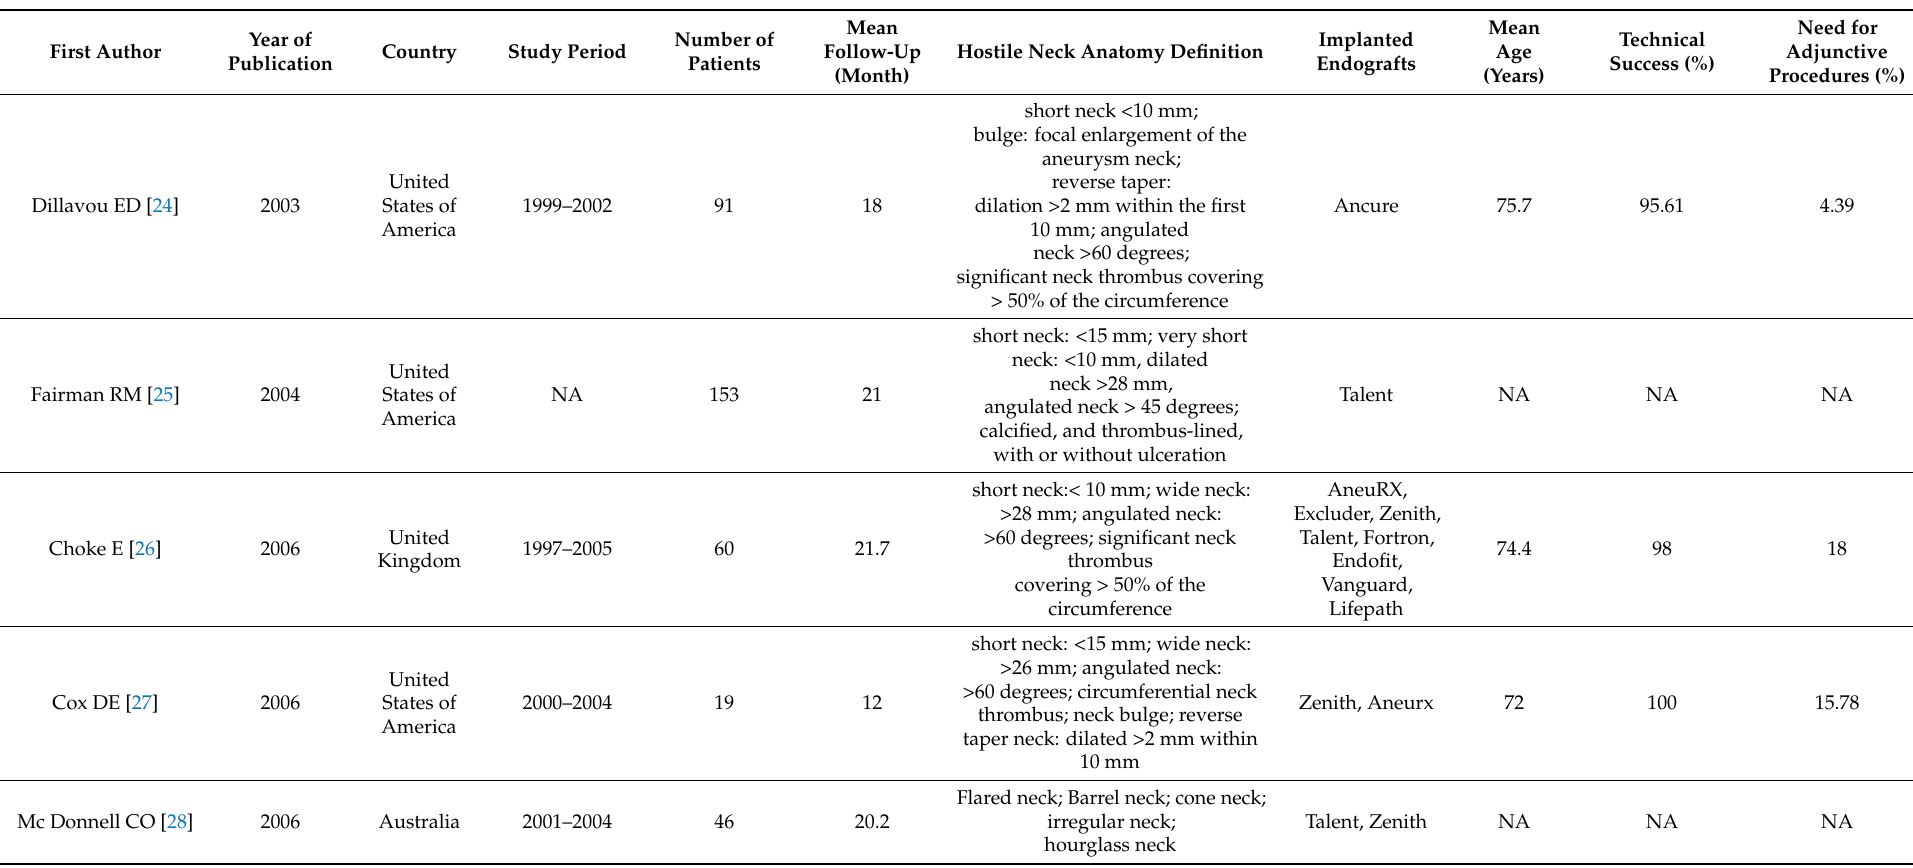
Table 1. Authors, years of publication, countries of origin, study period, number of patients, follow-up duration, type of endograft implanted, mean age, technical success, and need for adjunctive procedure rates of the 52 studies selected for the